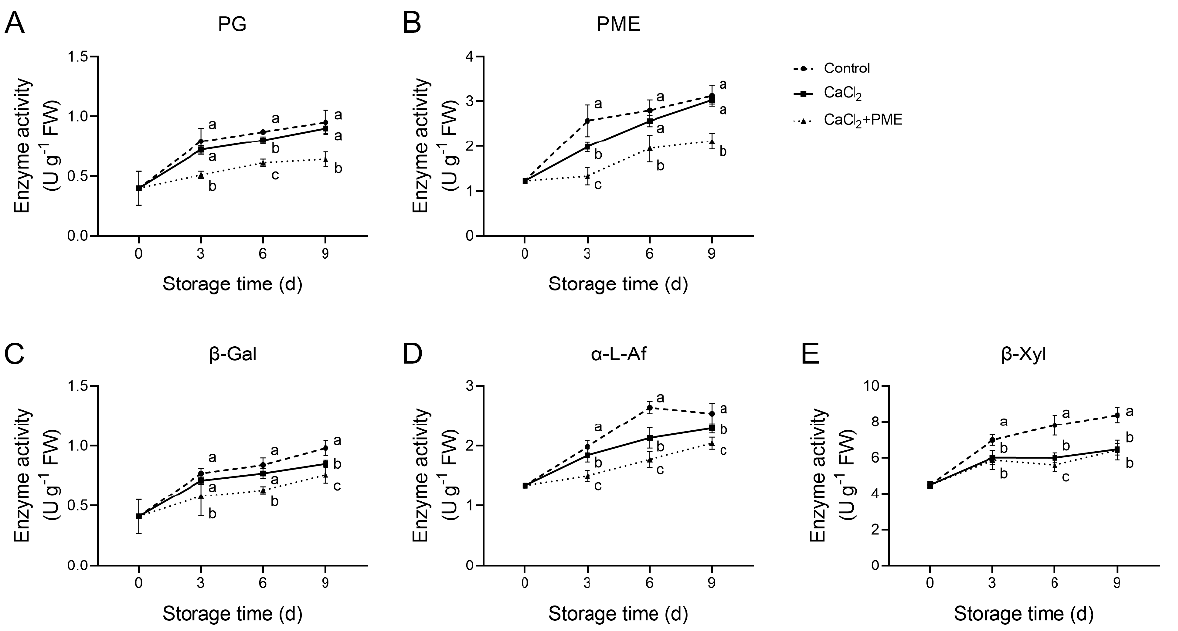
Figure 3. Effects of different treatments on the activities of the cell wall degradation enzymes of raspberry fruit. Data presented were based on three replicates. Vertical bars represent standard deviations of the means. Different lowercase letters indicate the significant differences among the treatments ( p < 0.05). PG: polygalacturonase; PME: pectin methyles ‐ terase; β‐ Gal: β‐ galactosidase; α‐ L ‐ Af: α‐ L ‐ arabinofuranosidase; β‐ Xyl: β‐ xylosidase.